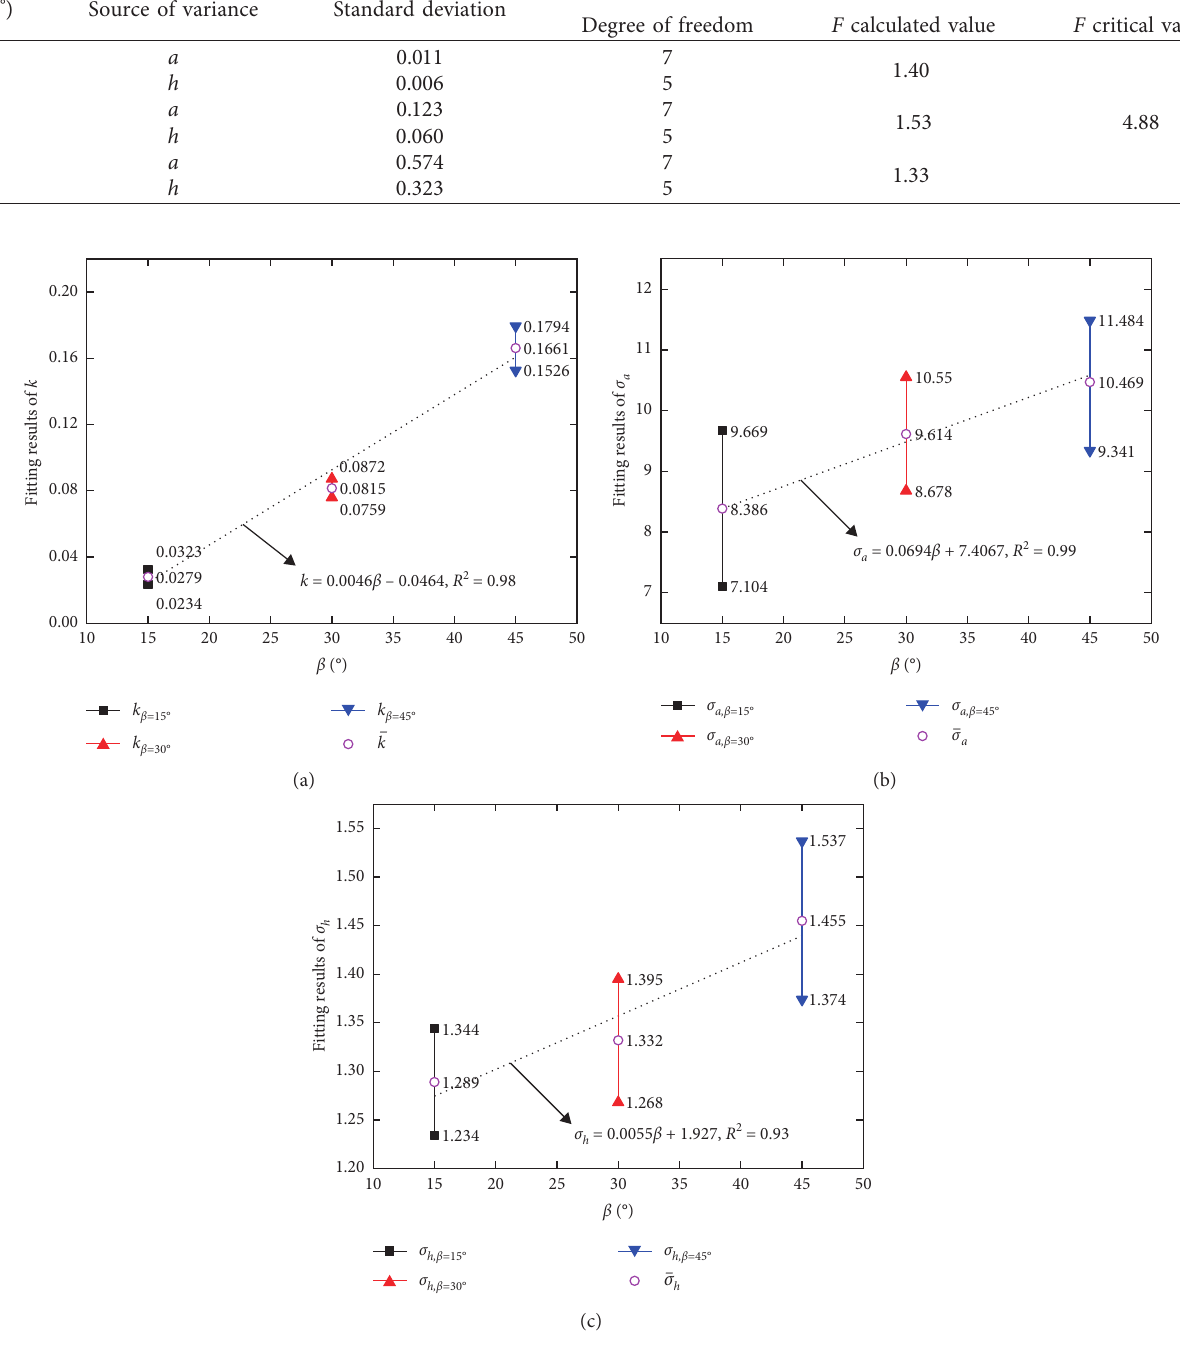
Figure 12: Fitting results of (a) k , (b) σ